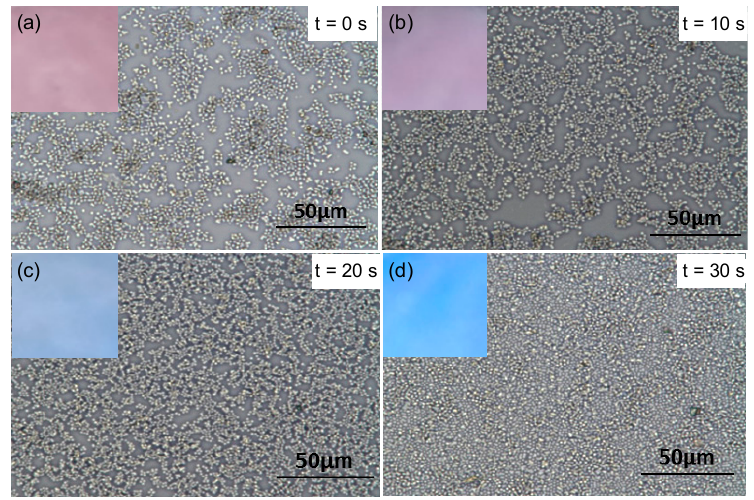
Figure 8. Real-time optical microscopy images of SPMs array from 0 to 30 s (i.e., images ( a – d )) after increasing the temperature above the LCST.